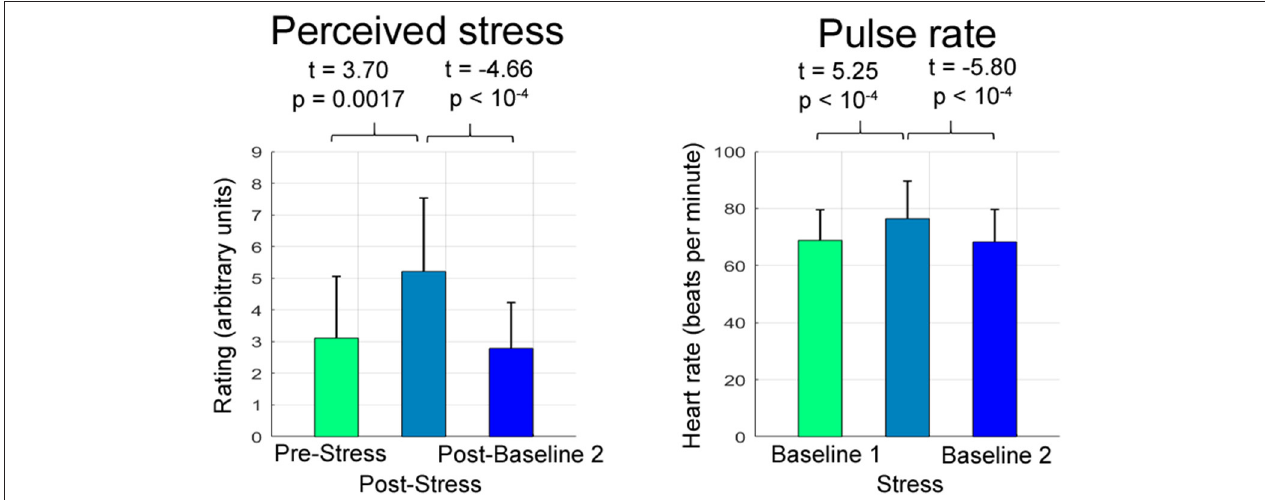
FIGURE 2 | Psychophysiological stress and relaxation responses. The bar graphs depict the mean and the standard deviation of raw perceived stress ratings and pulse rates (i.e., ratings and pulse rates not corrected for CNI) across participants separately for the respective experimental stage.